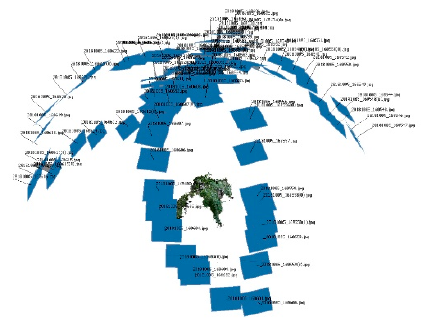
Figure 1. Position of the shoots during image acquisition.